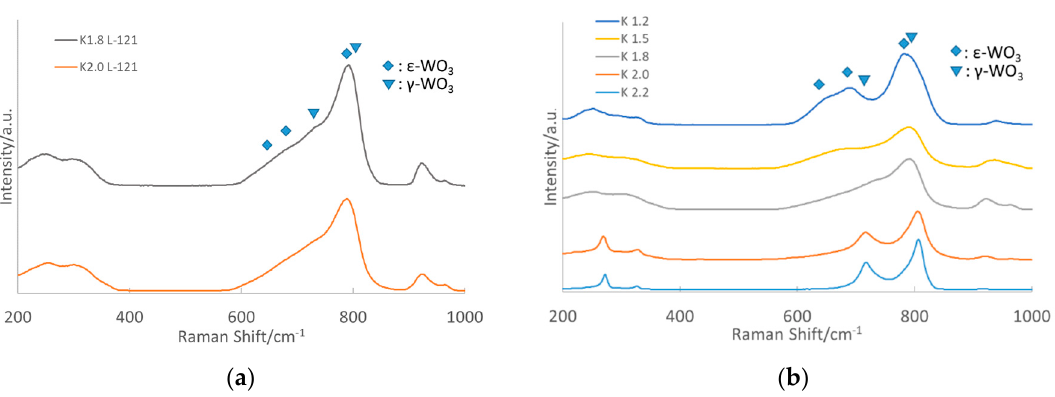
Figure 2. Raman of ( a ) K x WO with x = 1.8 and 2.0 grown with L-121 surfactant, and ( b ) K x WO with x = 1.2, 1.5, 1.8, 2.0, and 2.2.